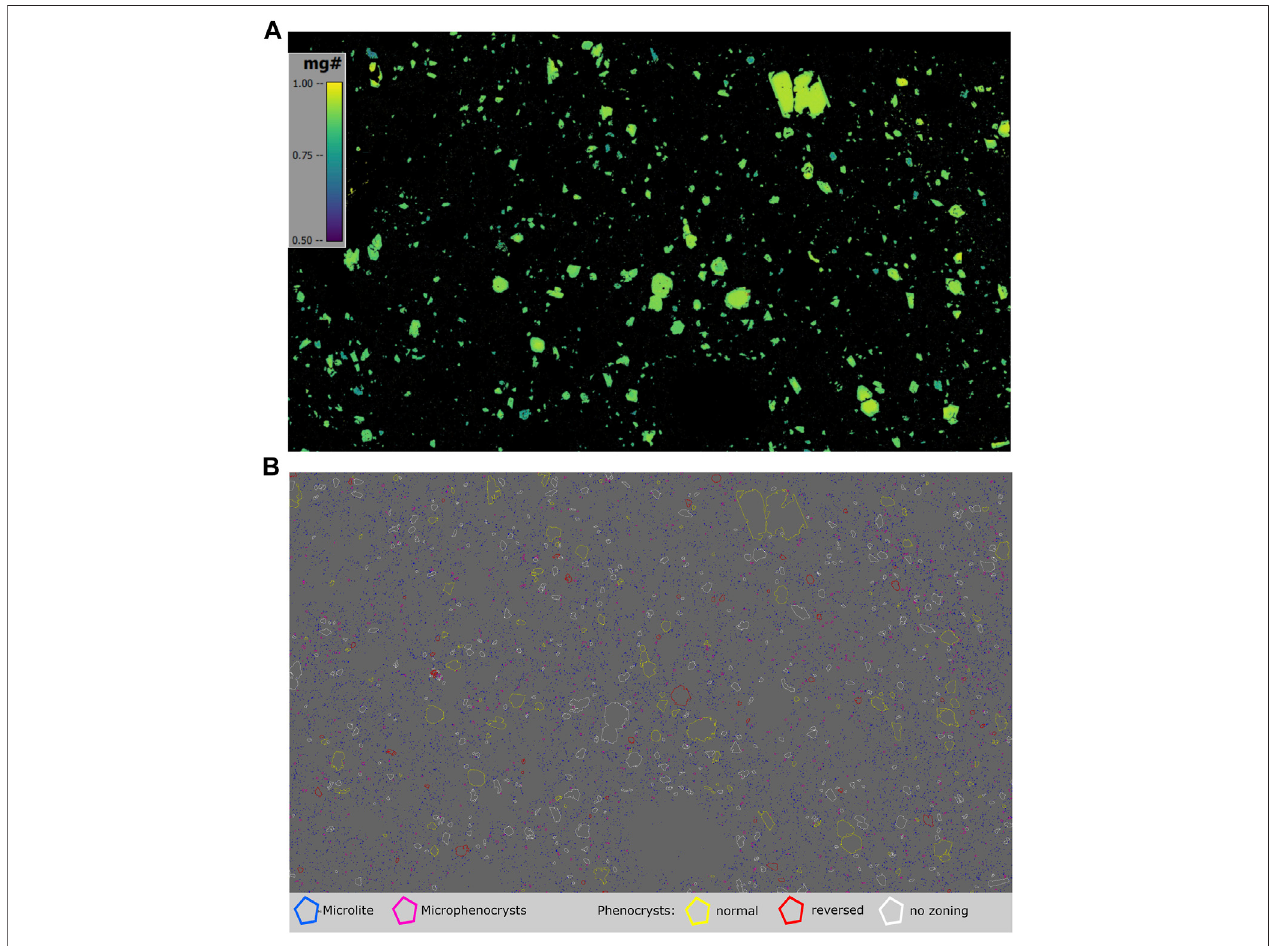
FIGURE 9 | Panel (A) Composite mg# -in-olivine map for the entire thin section produced from 9000 BSE tiles. Olivine segmentation is performed by DL. Values of mg# arerecoveredfromBSEgreyintensitiesofrepresentativeolivinesusingmicroprobecompositionaldata.Theoriginalimagehasaresolutionof1pixel~ 1micronand requires 30 Gb of memory. Panel (B) Thin section image with highlighted olivine crystals classi fi ed into fi ve groups: microlites (blue color contours), microphenocrysts (magenta), phenocrysts with normal zoning (yellow), phenocrysts with reversed zoning (red) and phenocrysts with no zoning (white). See high resolution image